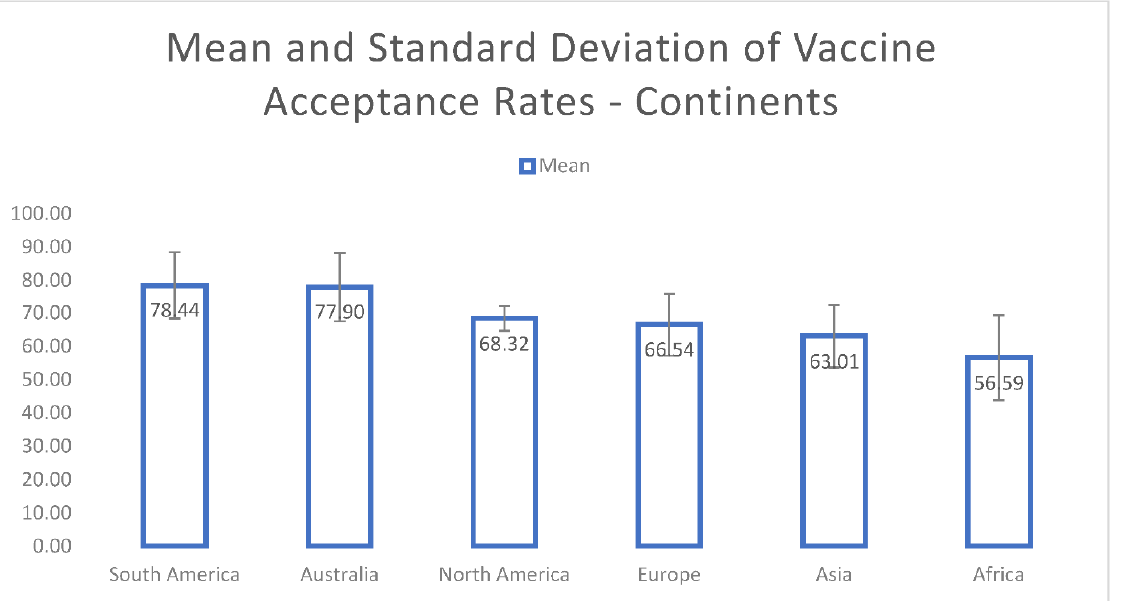
Figure 4. Mean and standard deviation of COVID-19 vaccine-acceptance rates for continents.